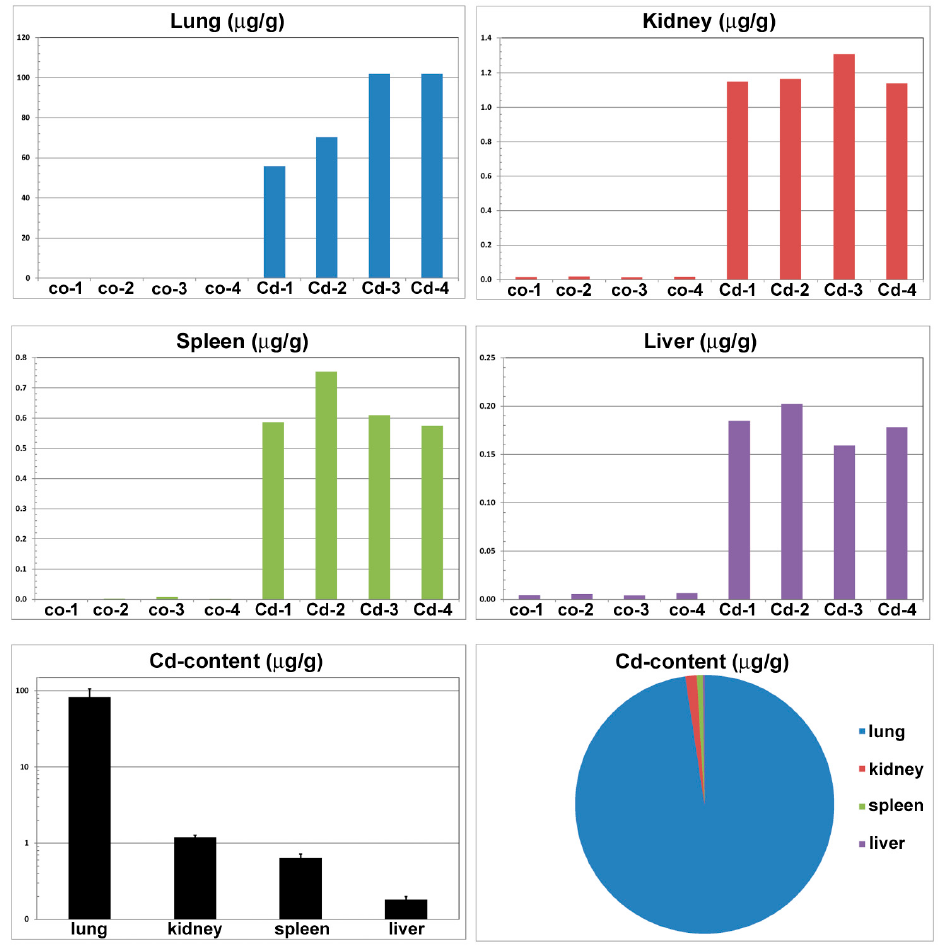
Figure 7. Content of cadmium in organs following six weeks exposure. Abbreviations in the X axis represent identification number of control mouse (co) or CdO nanoparticles inhalating mouse (Cd).